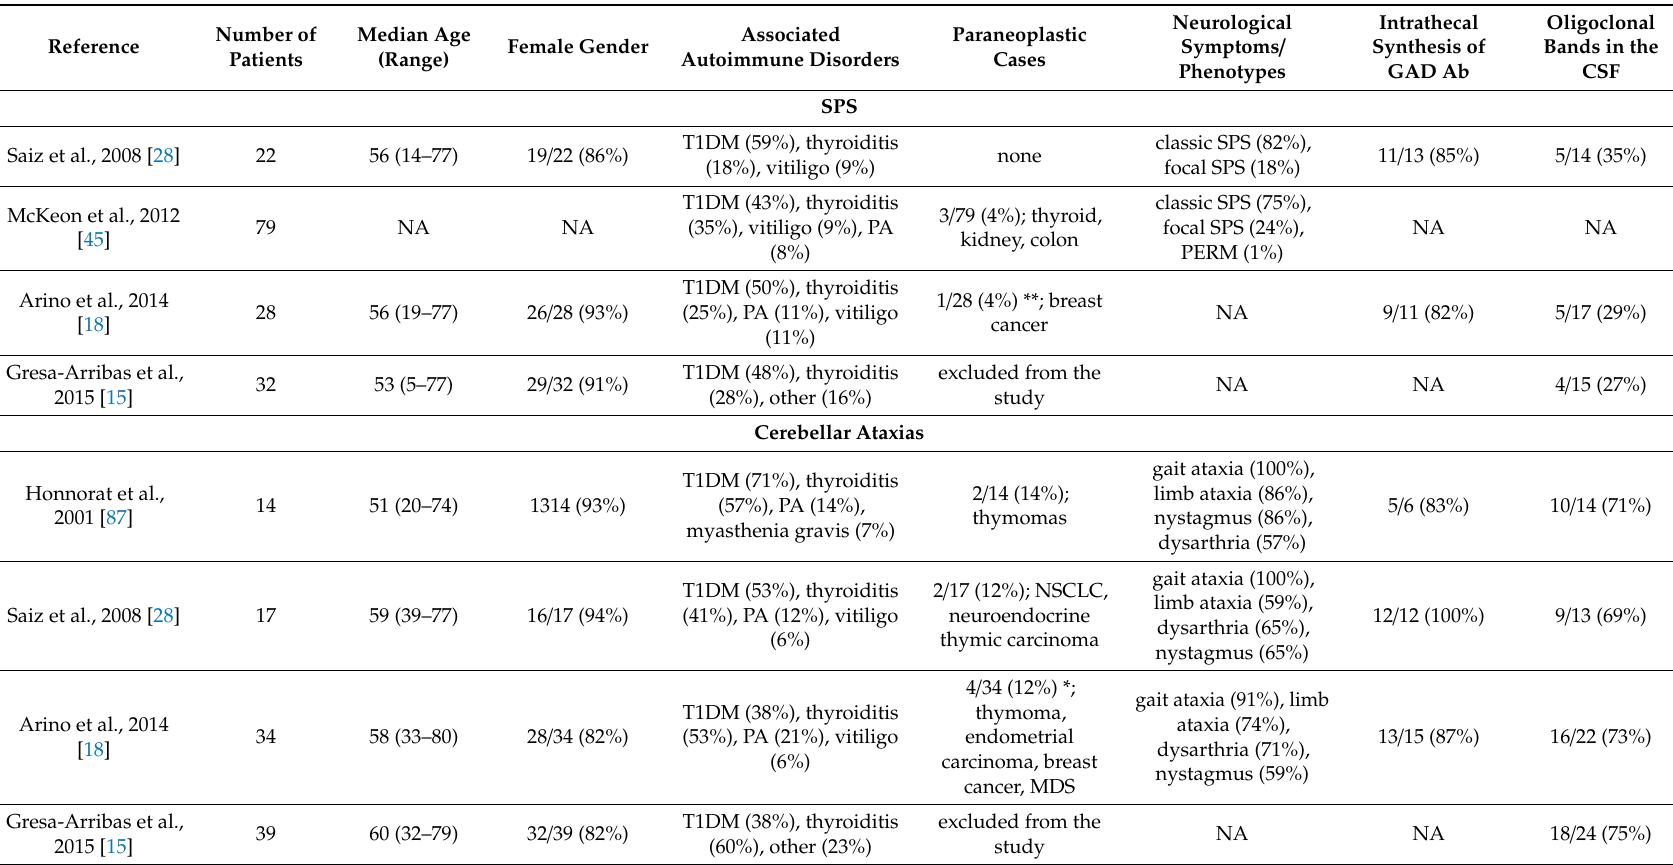
Table 1. Clinical and paraclinical characteristics of SPS, CA, and LE associated with GAD Ab in the main series reported in